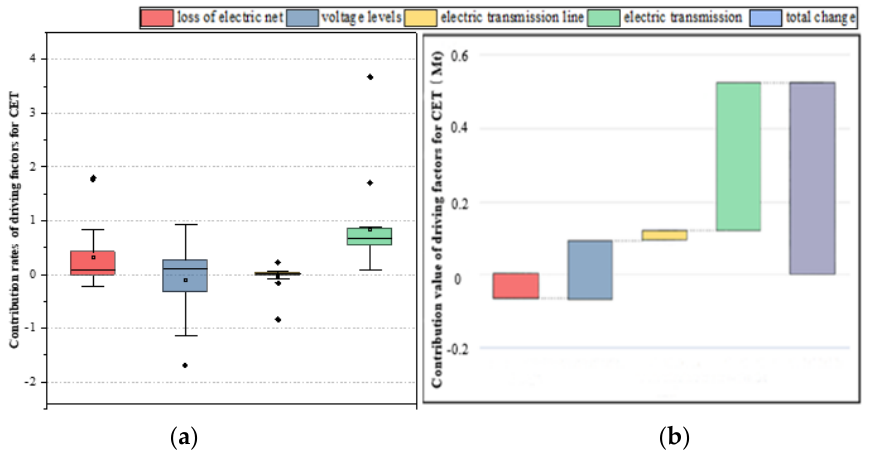
Figure 7. Contribution rates and contribution value of driving factors for CET. ( a ) Contribution rates of driving factors for CET. ( b ) Contribution value of driving factors for